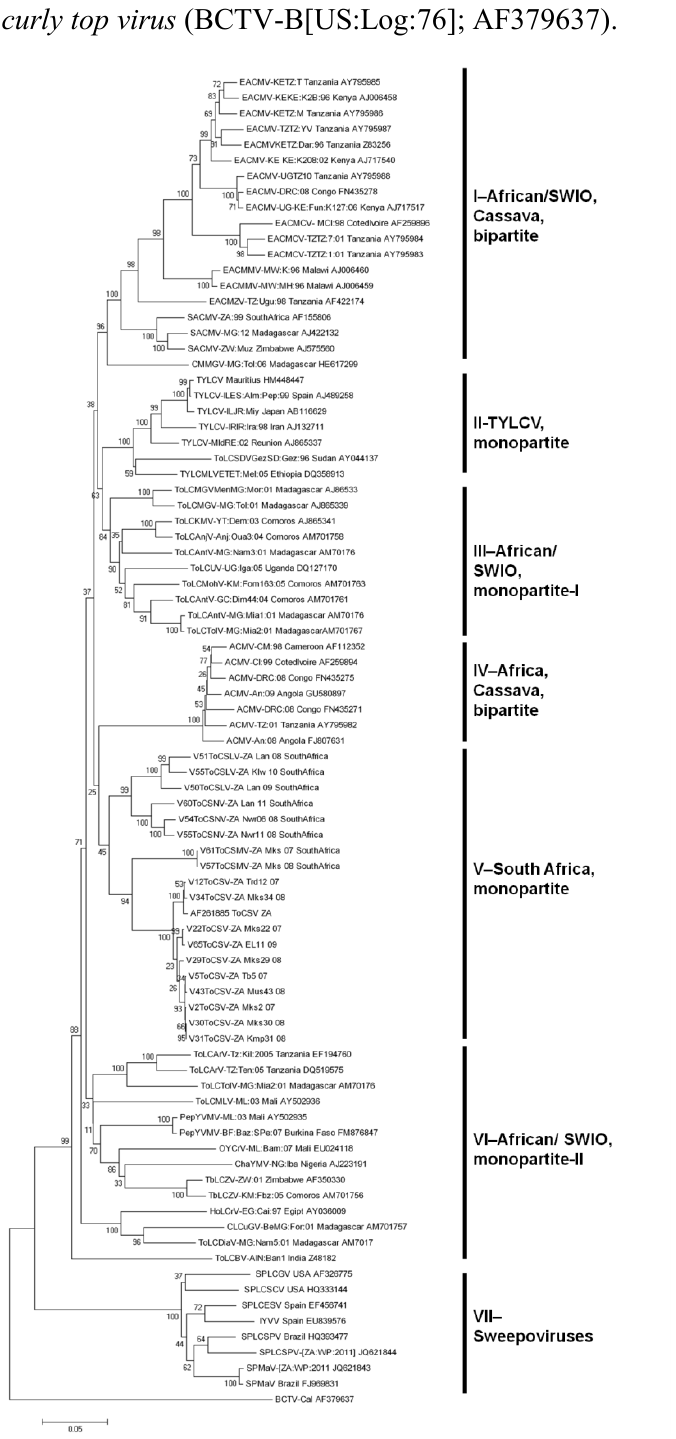
Figure 3. Neighbour joining phylogenetic tree indicating the relationship between the mono- and bipartite geminiviruses from southernSADC African countries and SWIO islands. Multiple sequence alignments were carried out using MUSCLE and phylogenetic analyses were performed using the neighbour-joining (NJ) and bootstrap option (1,000 replicates), available in Mega4.1. and Mega5.1. Horizontal branch lengths represent genetic distances as indicated by the scale bar, vertical distances are arbitrary. Representative begomovirus sequences obtained from Genbank are